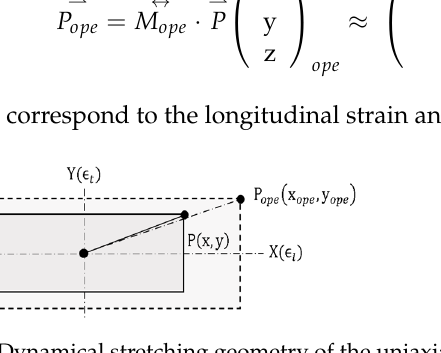
Figure 2. Effects of multi-directional stretching on the mold under external force: ( a ) forward external thrust and ( b ) angled external thrust.